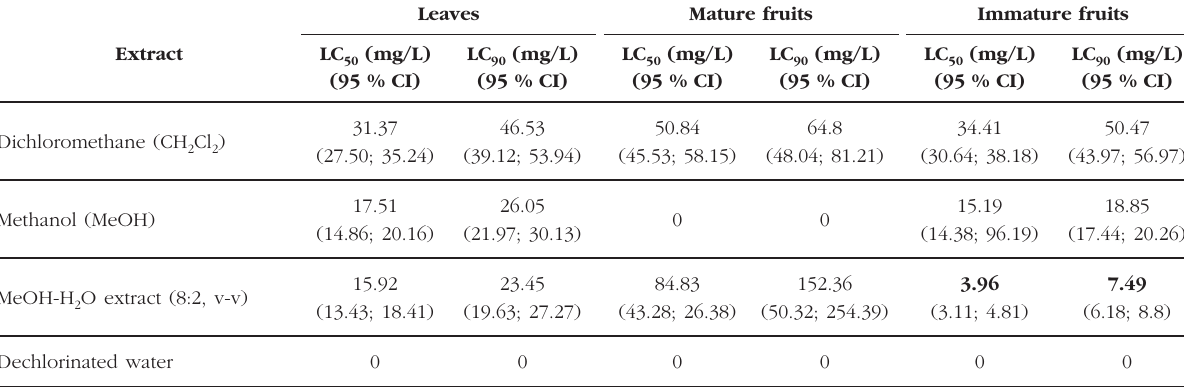
Leaves Mature fruits Immature fruits